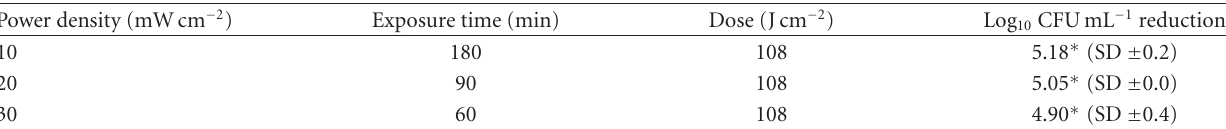
Table 1: The e ff ect of applying a dose of 108 Jcm − 2 using three di ff erent power density/exposure time regimes on the 405 nm light inactivation of L. monocytogenes in suspension.